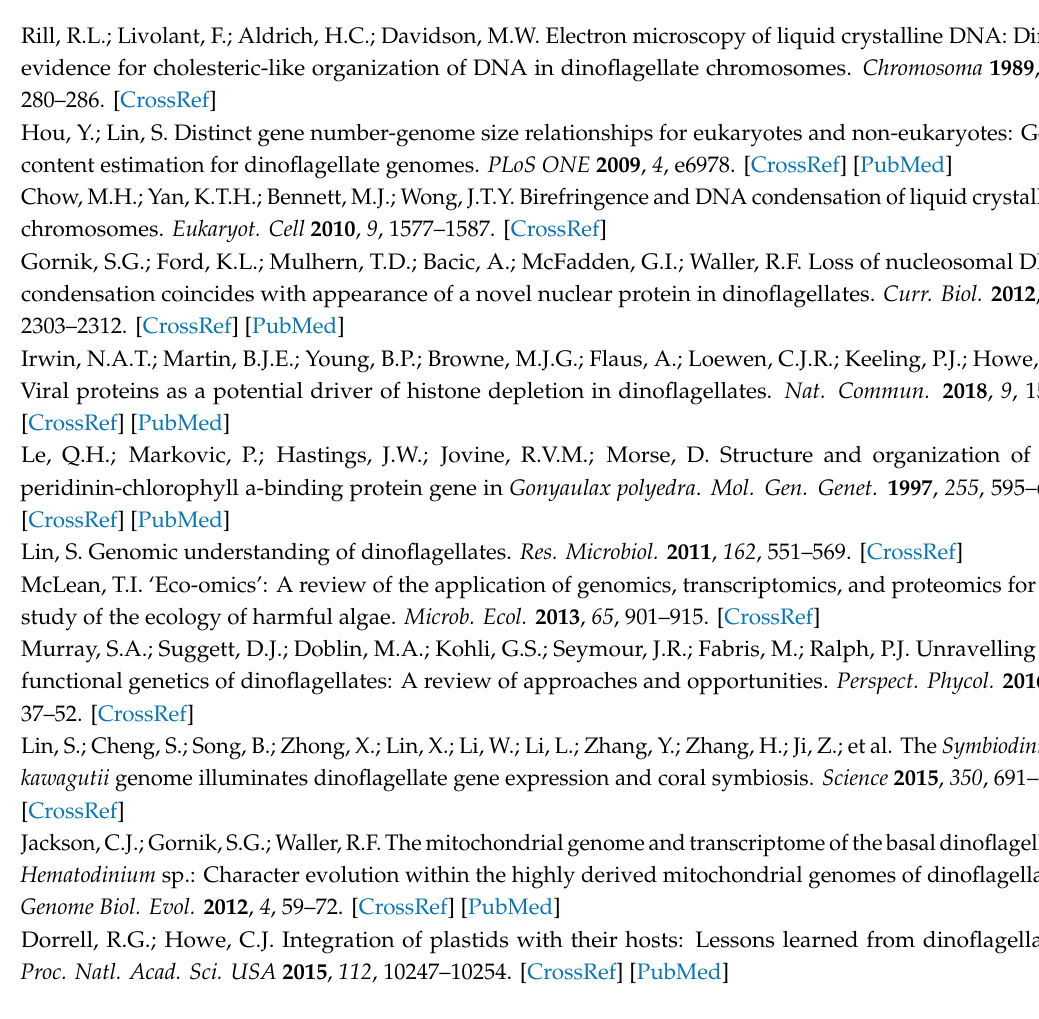
Sequence, Table S3: Termination Region Sequence, Table S4: DinoIII Sequence, Table S5: DinoIII- gfp Sequence, Table S6: DinoIII- arrO Sequence, Table S7: Codon Optimization Table for O. marina , Table S8: DinoIII- arrO- N Sequence, Video S1a: O. marina cells Transformed with GFP, Video S1b: O. marina cells Transformed with GFP 2, and Video S2: O. marina cells Transformed with